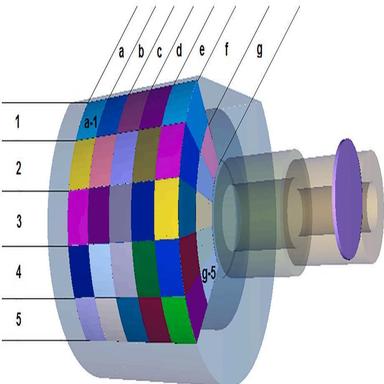
The large area activation detector placed on the target.